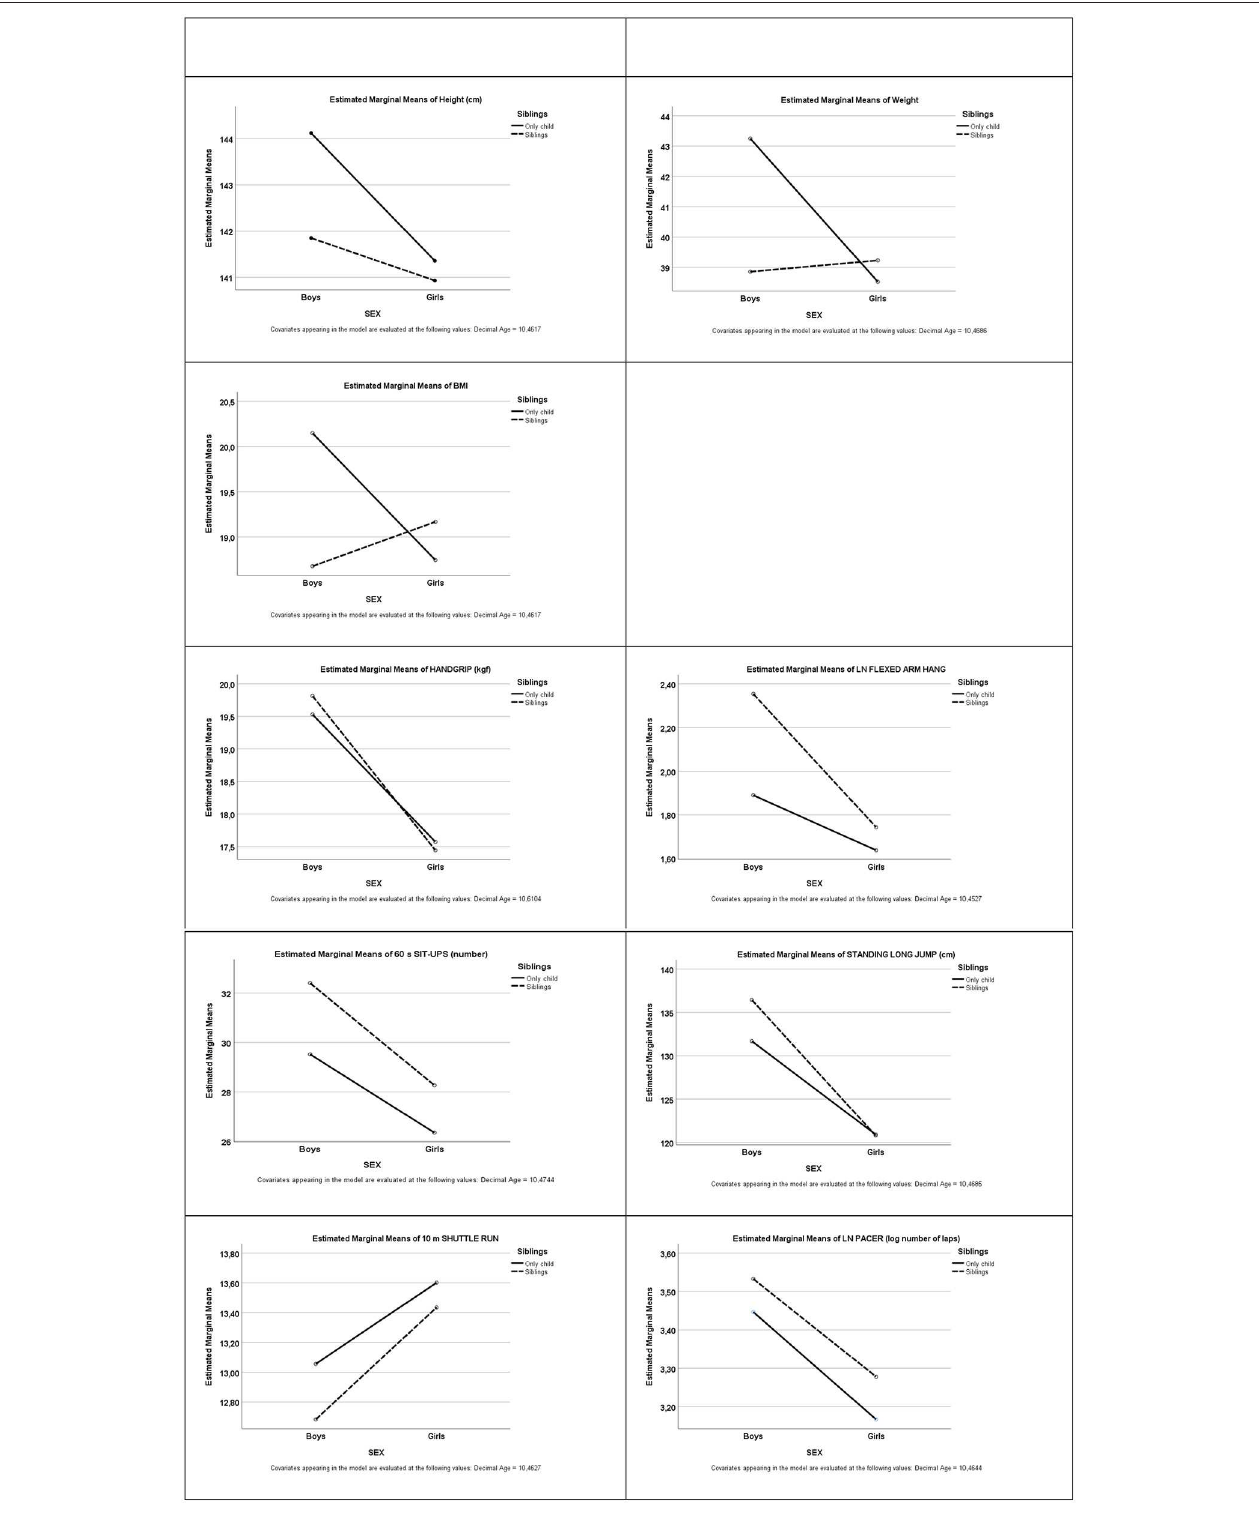
FIGURE 1 | Representation of the estimated marginal mean for somatic measures and physical fitness tests according to the number of siblings (only child or with siblings) by sex.